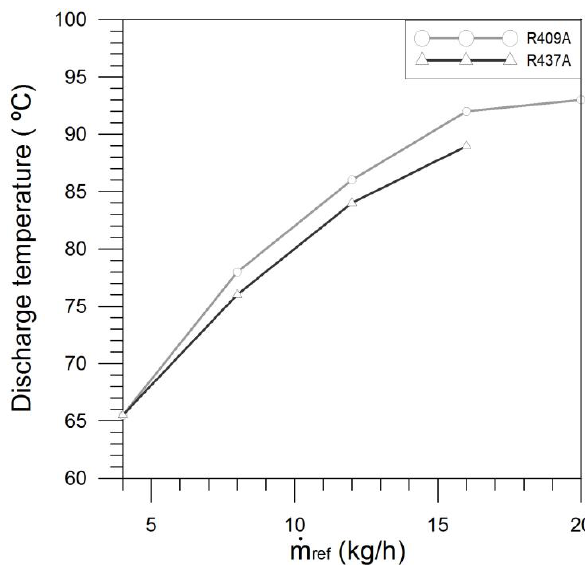
Figure 7: Effect of refrigerant flow rate on the compressor discharge temperature (Group B of tests).